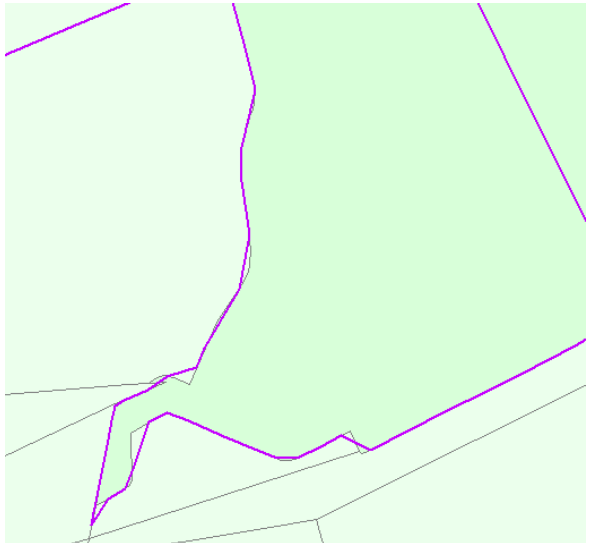
Figure 11. Adjustment result for a forest patch (test case